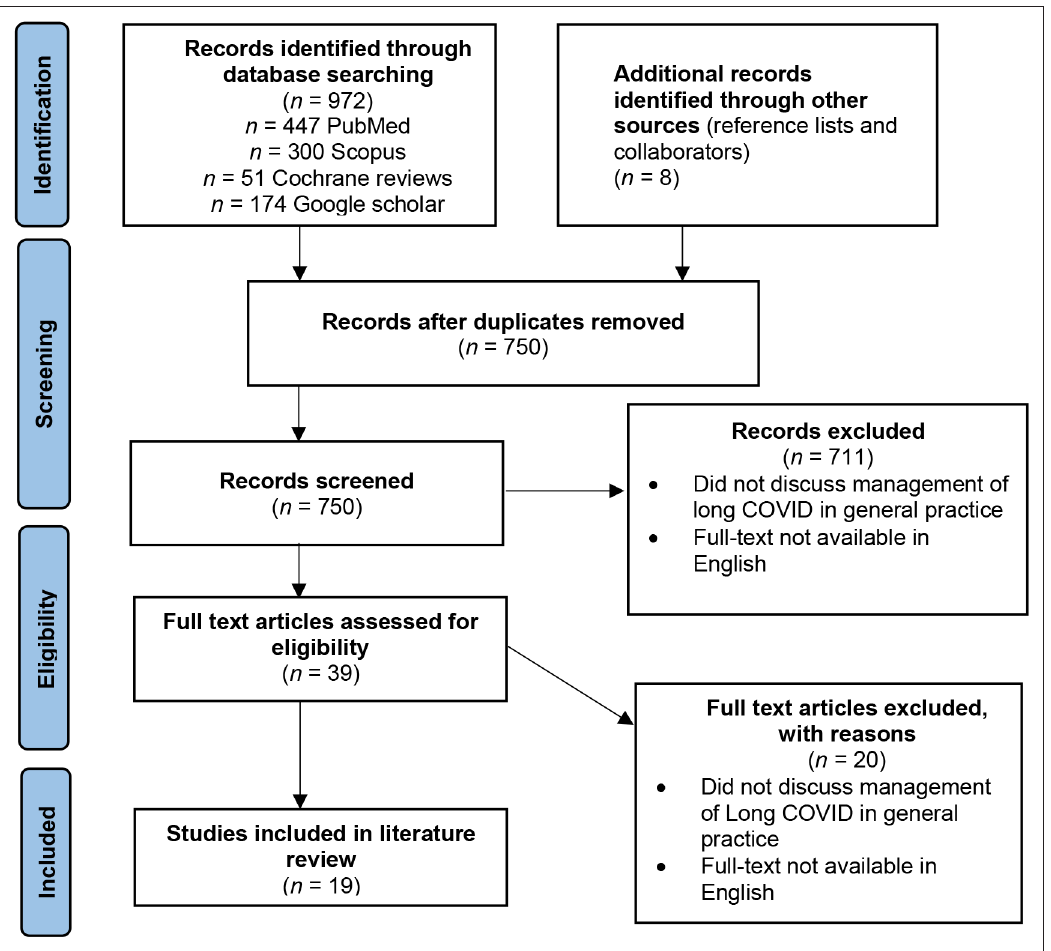
Figure 1 PRISMA extension for scoping reviews (PRISMA ScR)